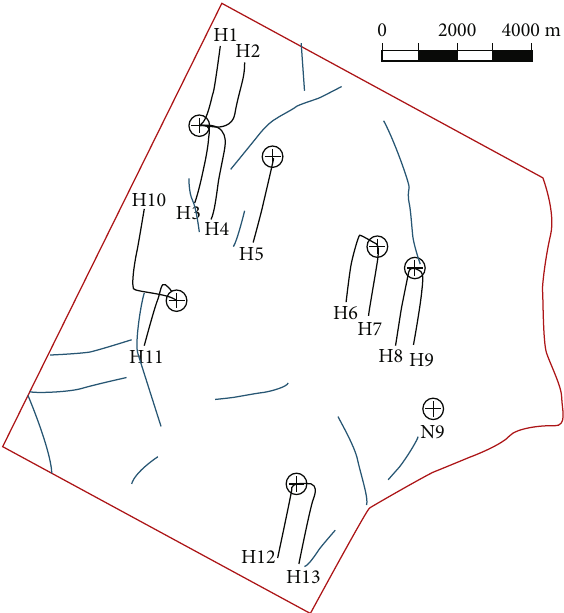
Figure 2: Faults system interpreted by seismic data in the study area.